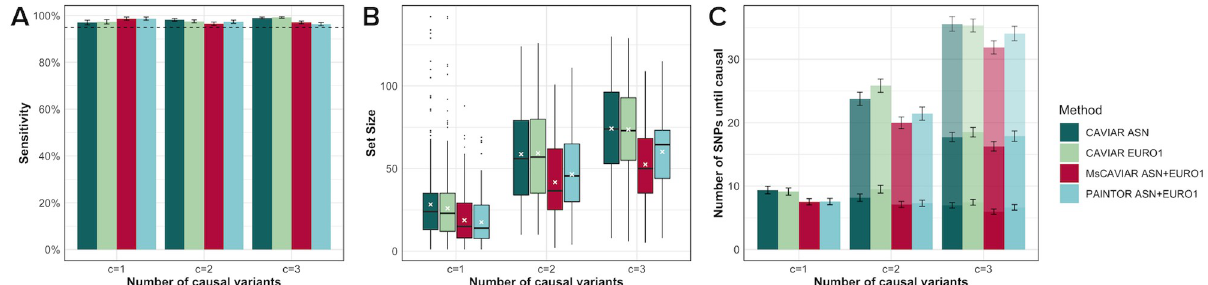
Fig 2. Comparison of sensitivity, precision, and set sizes using simulated data. We compare MsCAVIAR, PAINTOR, and CAVIAR with c 2 {1, 2, 3} causal variants implanted with results averaged over 20 replicates for 3 loci and 5 levels of heritability for all 3 values of c . (A) Bar graph indicating the sensitivity of each method with a dashed line to reflect the expected posterior probability, ρ , of recovering all causal SNPs (B) Box plots showing the average set sizes returned by the methods. Each box is the interquartile range of causal set sizes with the middle black line representing the median, and the white crosses showing the mean. (C) Bar graph displaying the average the number of SNPs in descending order of posterior inclusion probability (PIP) until 1, 2, or 3 causal SNPs is identified. Stacked bars represent increasing numbers of causal SNPs identified, until the true number of causal SNPs (x-axis) are